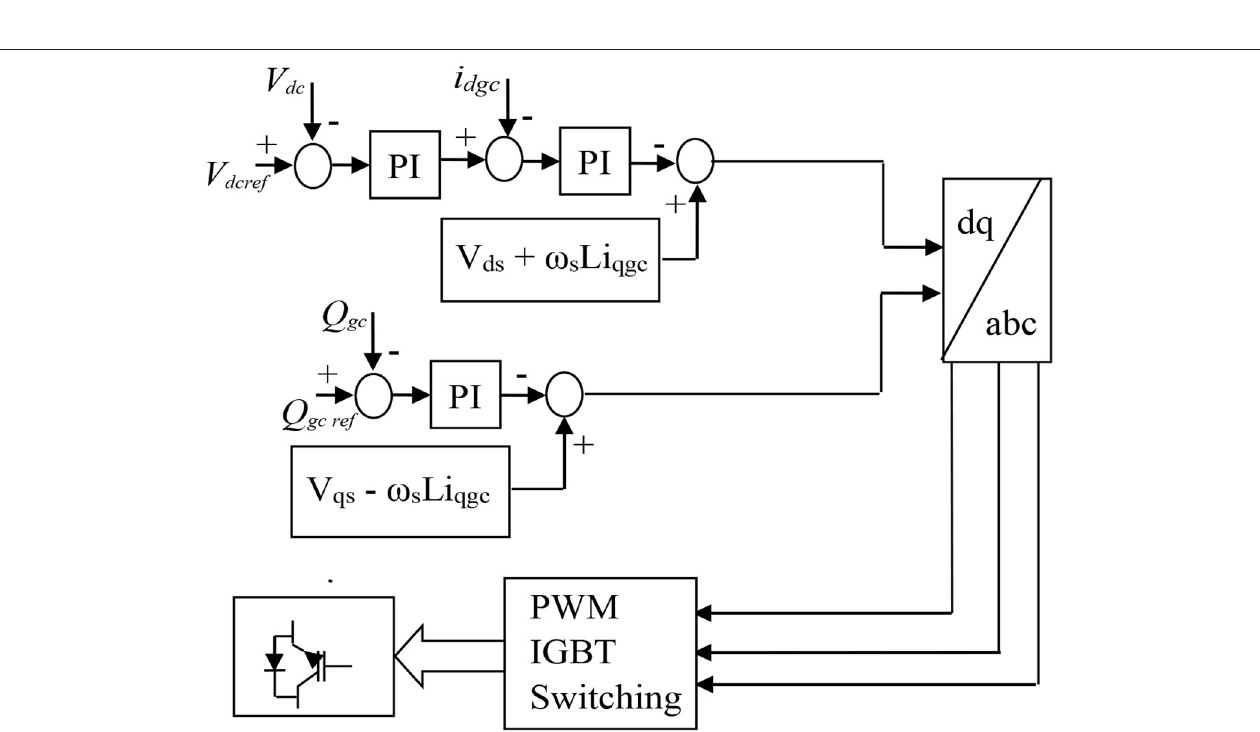
FIGURE 4 | The grid side converter control circuit of the